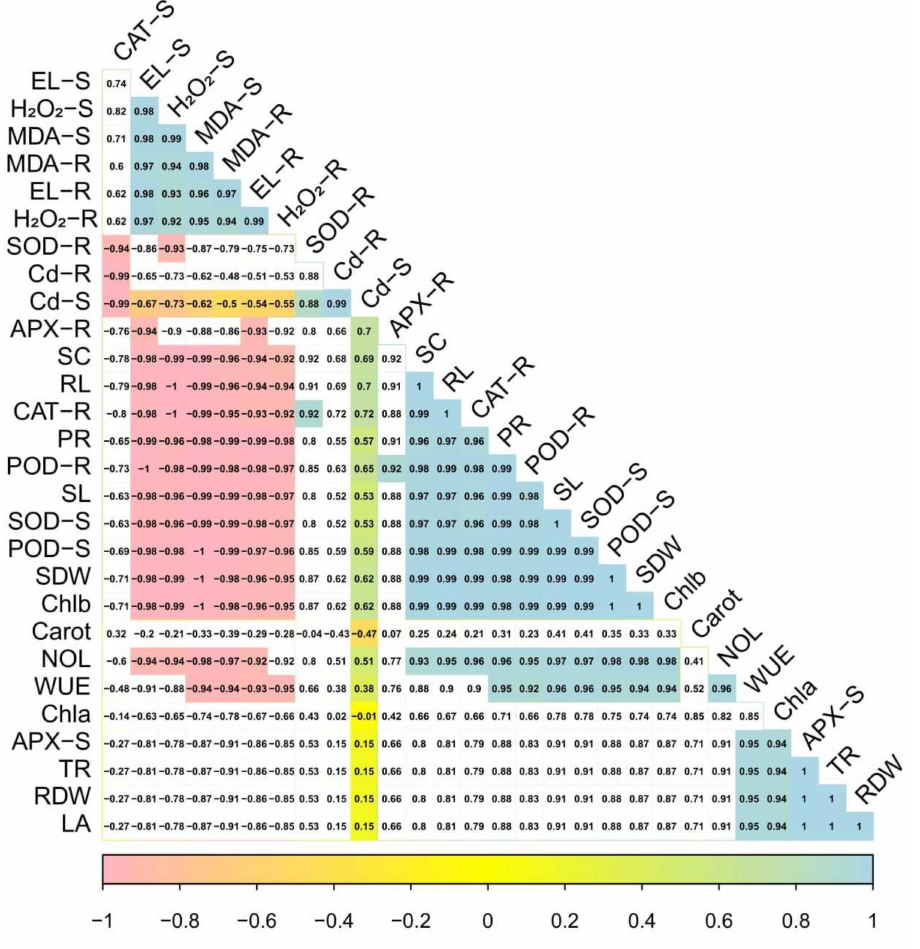
Figure 7. Correlation between growth and physiological parameters of S. nigrum grown under Cd contaminated soil with the application of S-Fertilizers. Different abbreviations used in the figure are as follows: Cd-R (Cd concentration in the roots) Cd-S (Cd concentration in the shoots), SL (shoot length), RL (root length), SDW (shoot dry weight), RDW (root dry weight), NOL (number of leaves), LA (leaf area), Chla (chlorophyll a), Chlb (chlorophyll b), Carrot (carotenoid contents), TR (transpiration rate), WUE (water use efficiency), PR (photosynthetic rate), SC (stomatal conductance), POD-S (peroxide activity in the shoots), POD-R (peroxide activity in the roots), SOD-S (superoxidase activity in the shoots), SOD-R (superoxidase activity in the roots), CAT-S (catalase activity in the shoots), CAT-R (catalase activity in the roots), APX-S (ascorbate peroxidase activity in the shoots), APX-R (ascorbate peroxidase in the roots) EL-S (electrolyte leakage in the shoots), EL-R (electrolyte leakage in the roots), H 2 O 2 -S (hydrogen peroxide content in the shoots), H 2 O 2 -R (hydrogen peroxide content in the roots), MDA-S (malondialdehyde contents in the shoots) and MDA-R (malondialdehyde contents in the